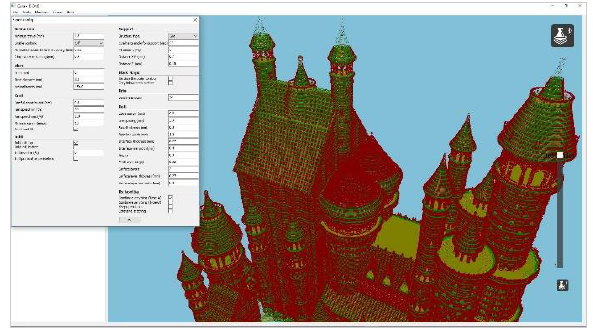
Figure 7. The expert settings screen of Cura: medieval castle model